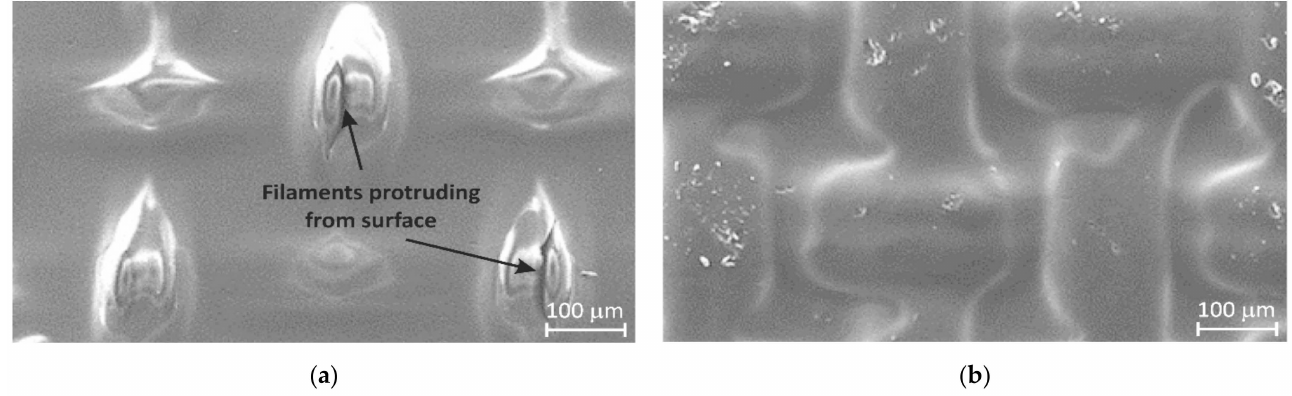
Figure 4. SEM images of the rougher surface of the pristine CJMA-7 membrane ( a ) and this surface after modification with a perfluorinated sulfonated ionomer LF-4SK ( b